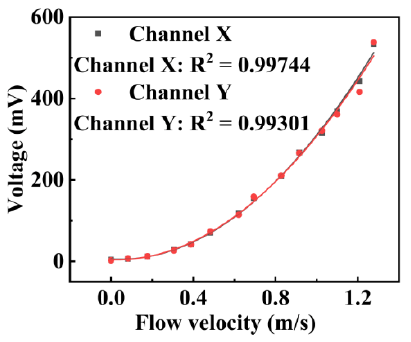
Figure 11. Results of the turbulence calibration